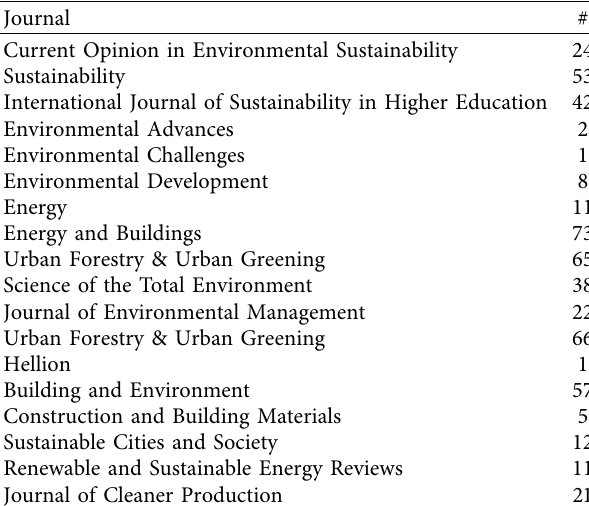
Table 1: The number of selected studies for each